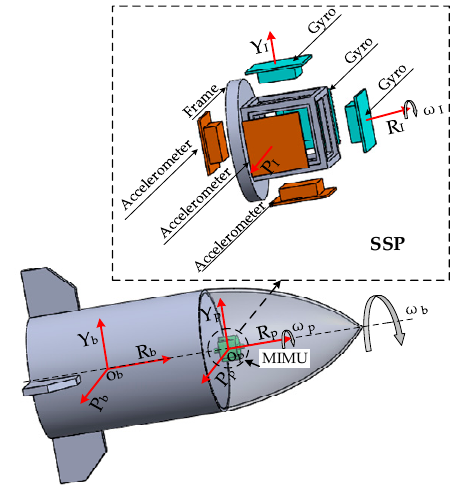
Figure 3. The schematic diagram of the relative position of Micro Inertial Measurement Unit (MIMU).